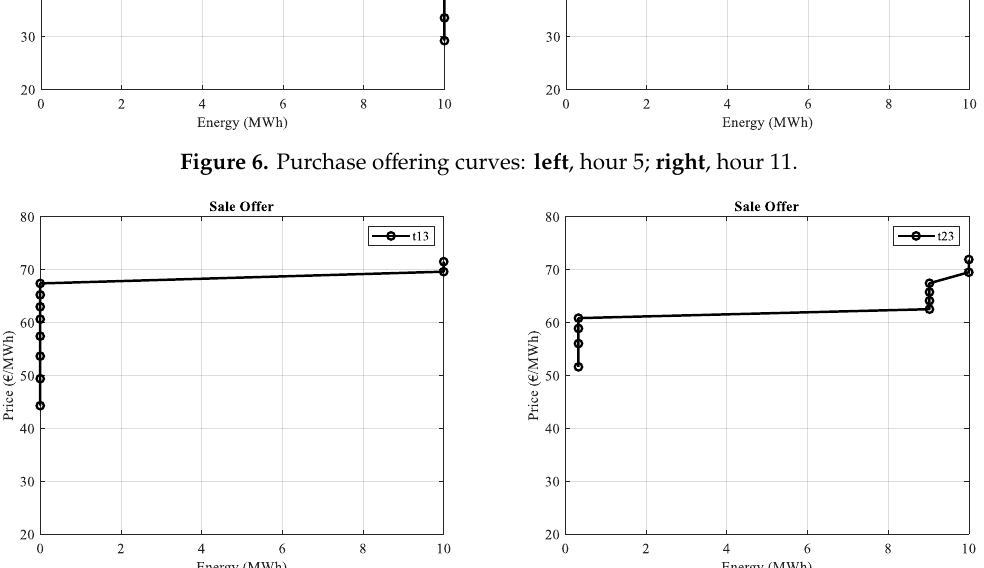
Figure 7. Sale o ff ering curves: left , hour 13; right , hour Figure 7. Sale offering curves: left , hour 13; right , hour 23. Figure 7. Sale offering curves: left , hour 13; right , hour 23.